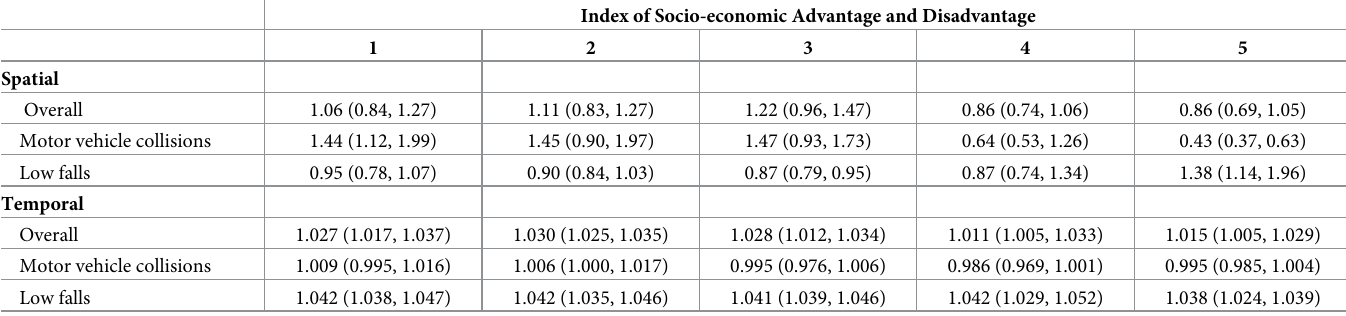
Table 4. Summaries of the posterior means of the area-specific relative risk (‘Spatial’) and the area specific yearly multiplicative change in risk (‘Temporal’) grouped by the Index of Relative Socio-economic Advantage and Disadvantage (IRSAD), classified from 1 (most disadvantage), to 5 (most